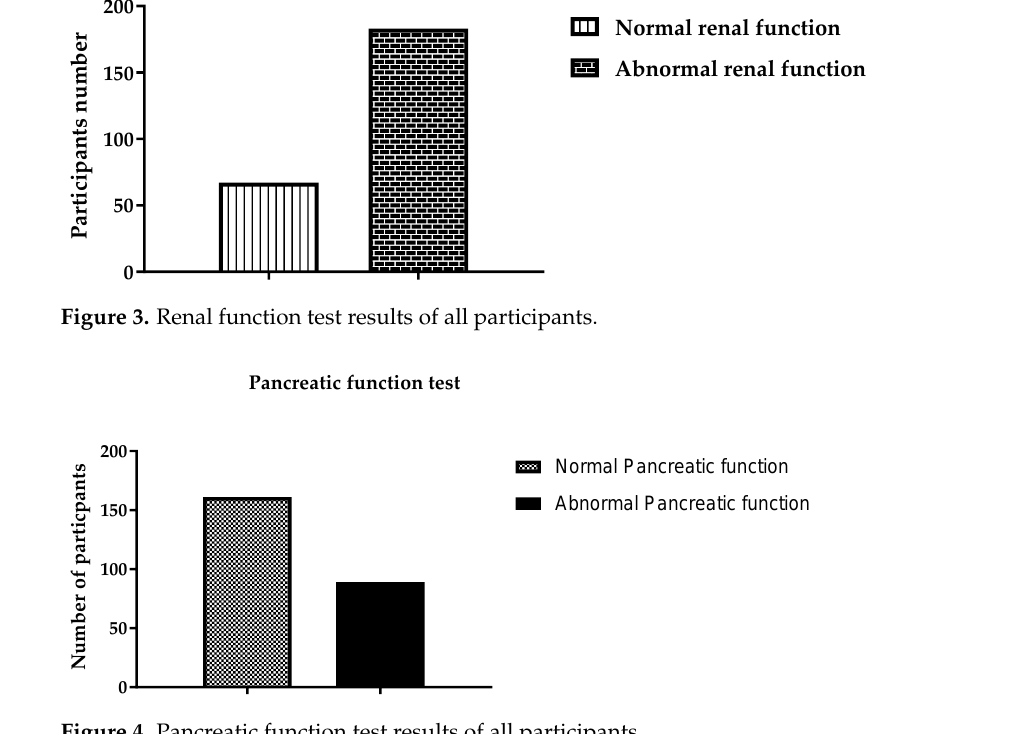
Figure 4. Pancreatic function test results of all participants.